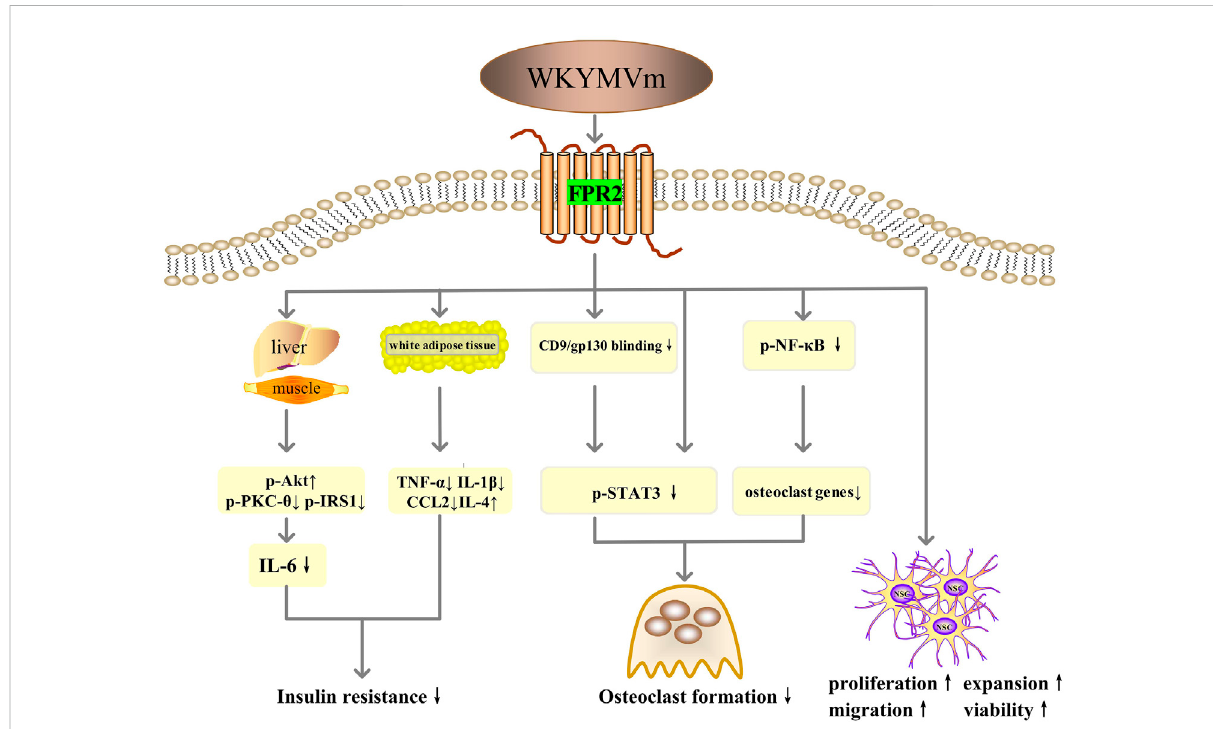
FIGURE 5 WKYMVm with insulin resistance, osteolytic diseases and neurodegenerative diseases. WKYMVm ameliorates insulin resistance by sensitizing theinsulinpathwayinmetabolictissues(skeletal muscleandliver),and modulatingtheexpressionofin fl ammatorycytokines inwhite adiposetissue. WKYMVmalleviatesosteolysis byinhibitingtheformationofosteoclasts,directlythroughNF- κ BandSTAT3signalingpathway andindirectly through CD9/gp130/STAT3 pathway. WKYMVm promotes the proliferation, expansion, chemotactic migration and viability of NSCs to alleviate neurodegenerative diseases. p-Akt, Akt phosphorylation; p-PKC- θ , protein kinase C- θ phosphorylation; p-IRS1, insulin receptor substrate 1 phosphorylation; IL, interleukin; TNF- α , tumor necrosis factor alpha; CCL2, C-C motif chemokine ligand 2; gp130, glycoprotein 130; p-STAT3, signal transducer and activator of transcription 3 phosphorylation; p-NF- κ B, nuclear factor-kappa B phosphorylation; NSC, neural stem cell. ↑ , increase; ↓ ,